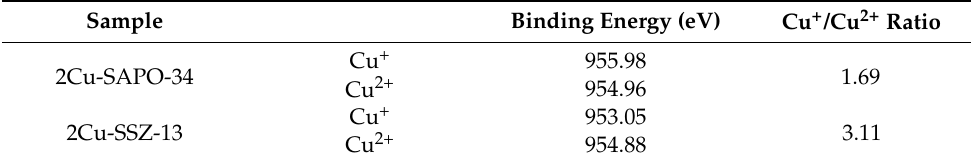
Figure 4. Diffuse reflectance UV–Vis spectra of the 2Cu-SAPO-34 and 2Cu-SSZ-13 samples. Table 3. XPS results for the Cu-CHA zeolite